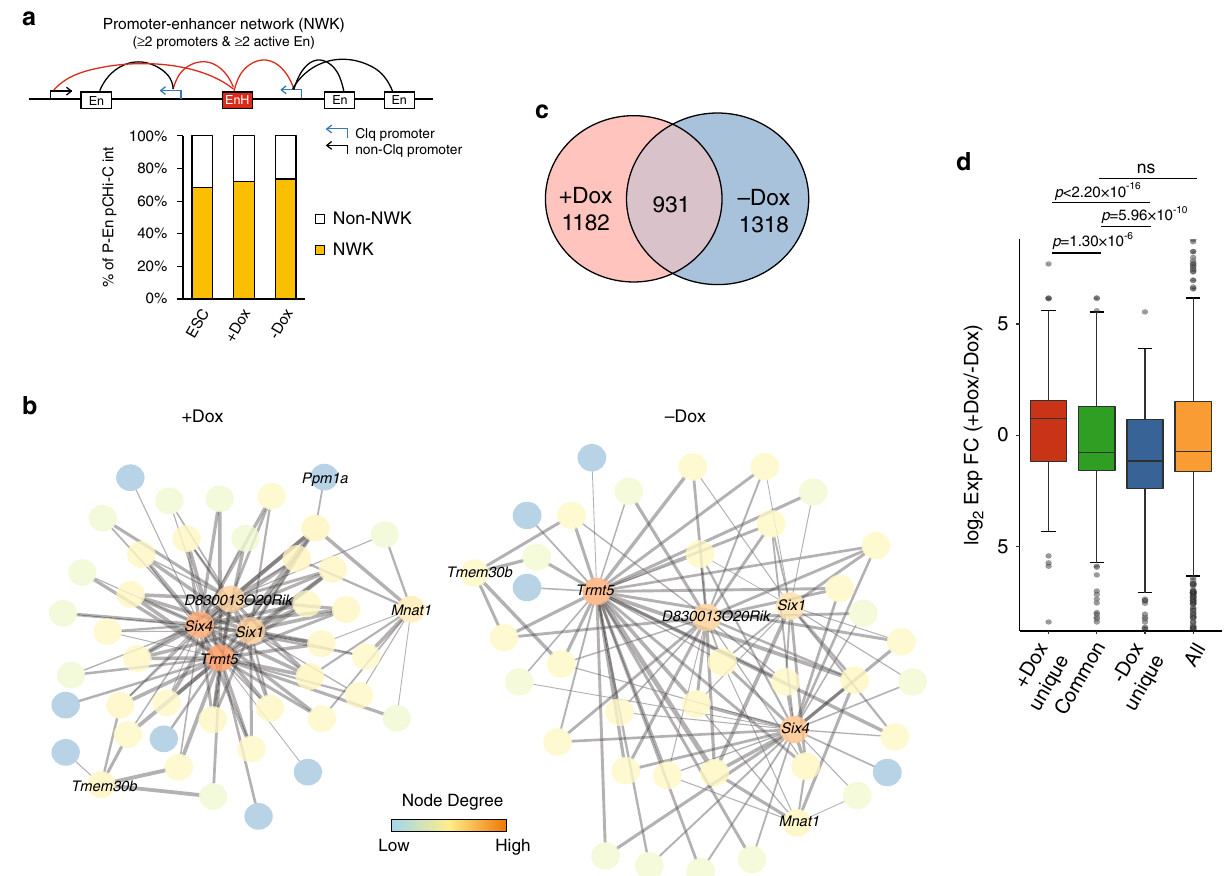
Fig. 6 A structural and functional role for enhancer hubs (EnHs) in forming P – En networks during myogenic differentiation. a Identi fi cation of P – En networks (NWK) in ESCs ( n = 261), + Dox ( n = 790), and – Dox ( n = 880) iPax7 cells. (Top) Schematic of a P – En network connected through an EnH (in red). (Bottom) Quanti fi cation of P – En interactions involved in P – En networks in each population. b P – En networks of the Six1/4 locus in + Dox and − Dox iPax7 cells graphed with Cytoscape. No network was detectable at these loci in ESCs. Each node represents a pCHi-C captured region, and promoters were labeled with their corresponding gene names, while enhancers were left unlabeled. Each gray line between nodes represents a high-con fi dence pCHi-C interaction, and the thickness of the line indicates the strength of the interaction measured by the CHiCAGO score. Node degree from low to high re fl ects the relative frequency of connections from one node to other nodes within the motif. c Overlap between EnHs in + Dox and − Dox iPax7 cells. d Corresponding transcriptional changes during iPax7 cell differentiation for target genes in each EnH group from c . Only differentially expressed genes ( p adj < 0.05 from paired DESeq2) are included ( n = 446, 430, and 547 for group ‘ + Dox unique ’ , ‘ Common ’ , and ‘ − Dox unique ’ , respectively). All differentially expressed genes in iPax7 cells ( n = 2831) are used as a control. The boxes denote the 25th and 75th percentile (bottom and top of box), and median value (horizontal band inside box). The whiskers indicate the values observed within up to 1.5 times the interquartile range above and below the box. Statistical signi fi cance tested with two-tailed Student ’ s t